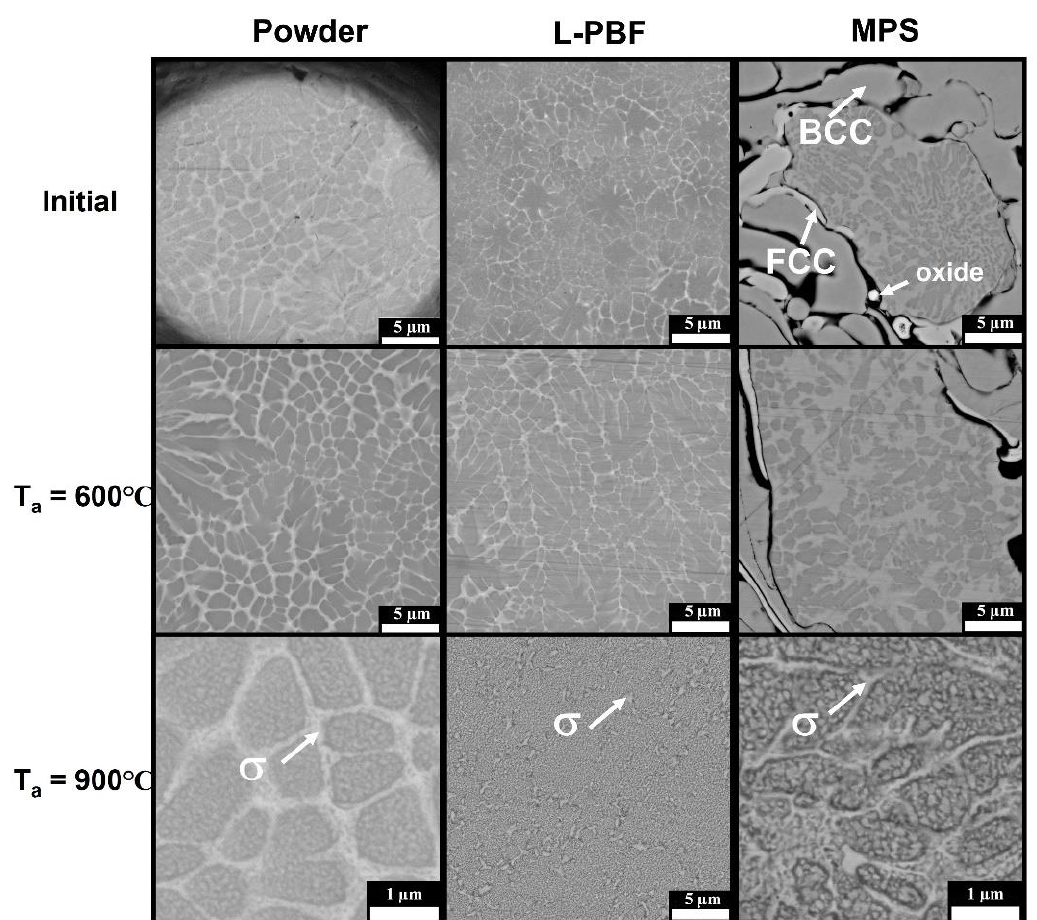
Figure 3. SEM microphotographs of the powder, L-PBF and MPS samples in an initial state and annealed at 600 °C and 900 °C.